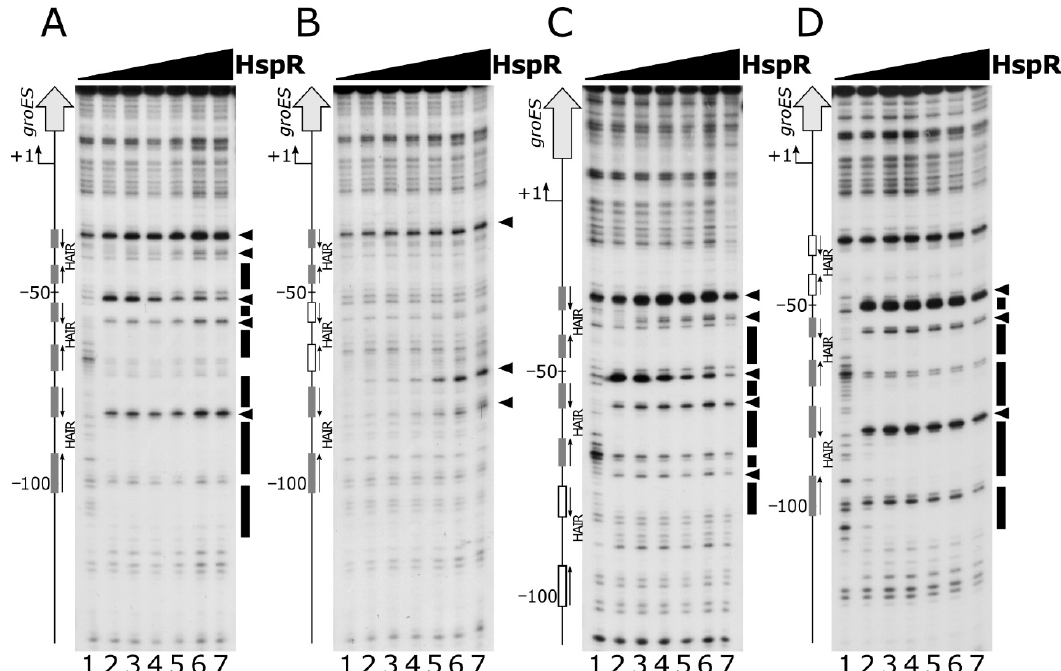
Figure 4. DNase I footprinting assays of HspR on wild type P gro (panel A ) or on a set of mutant probes, comprising the mutant of the central high ‐ affinity HAIR motif (panel B ) and of the flanking low ‐ affinity HAIR sequences (panel C and D ). Reaction conditions and symbols are the same as in Figure 3.